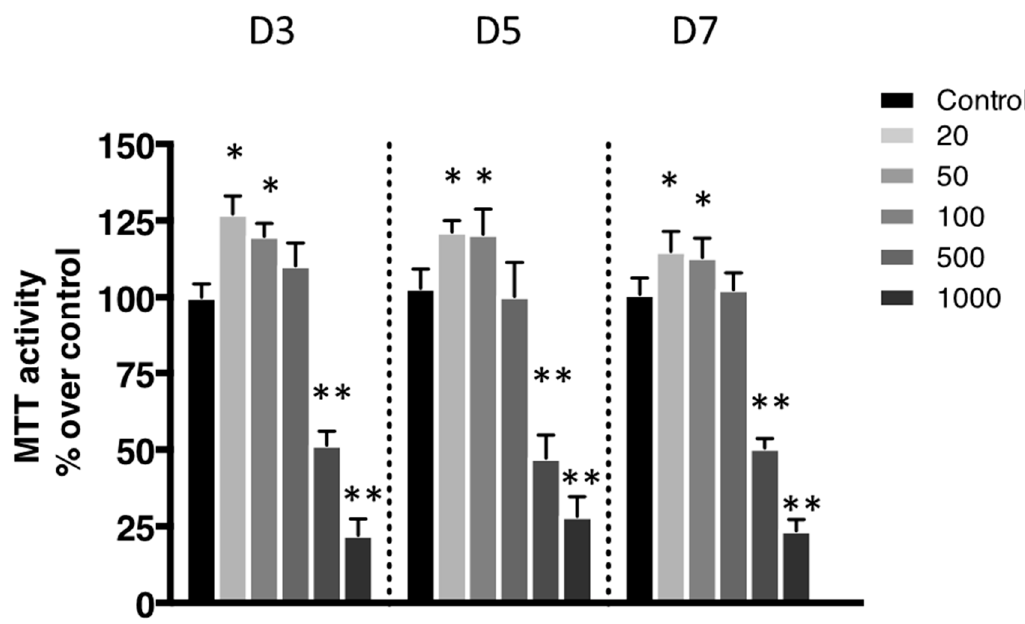
Figure 2. Impact of nanoliposomes on chondrocytes viability. Rat chondrocytes were exposed to increasing concentrations of nanoliposomes (20, 50, 100, 500, and 1000 µ g / mL) for 3, 5, and 7 days. Metabolic activity was assessed using the 3-(4,5-Dimethylthiazol-2-yl)-2,5-diphenyltetrazolium bromide (MTT) assay. The cell metabolic activity results on the di ff erent membranes are presented in % versus control results (as 100%). The results shown are mean ± SD of at least four individual experiments. * p < 0.01 and ** p < 0.001 compared to control for each time point.